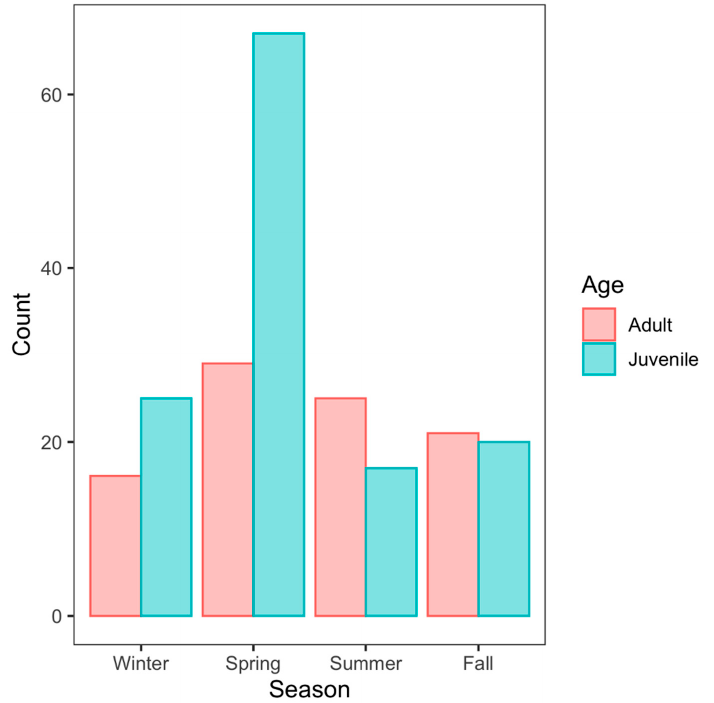
Figure 4. Age and Season. The relationship between age and seasonal activity. Seasons were based on biological behaviors. Winter included November-February and has been observed as an inactive period. Spring included March-May which was considered the mating season. Summer was June- July which is when snakes are often found foraging. Fall included August-October which is when snakes give birth. We found that age did not have an effect on the timing of observations (W = 4615.5, p = 0.566). Juveniles were found hunting 7.65 h after sunrise on average, while adults were found hunting 7.97 h after sunrise on average (Figure 5).